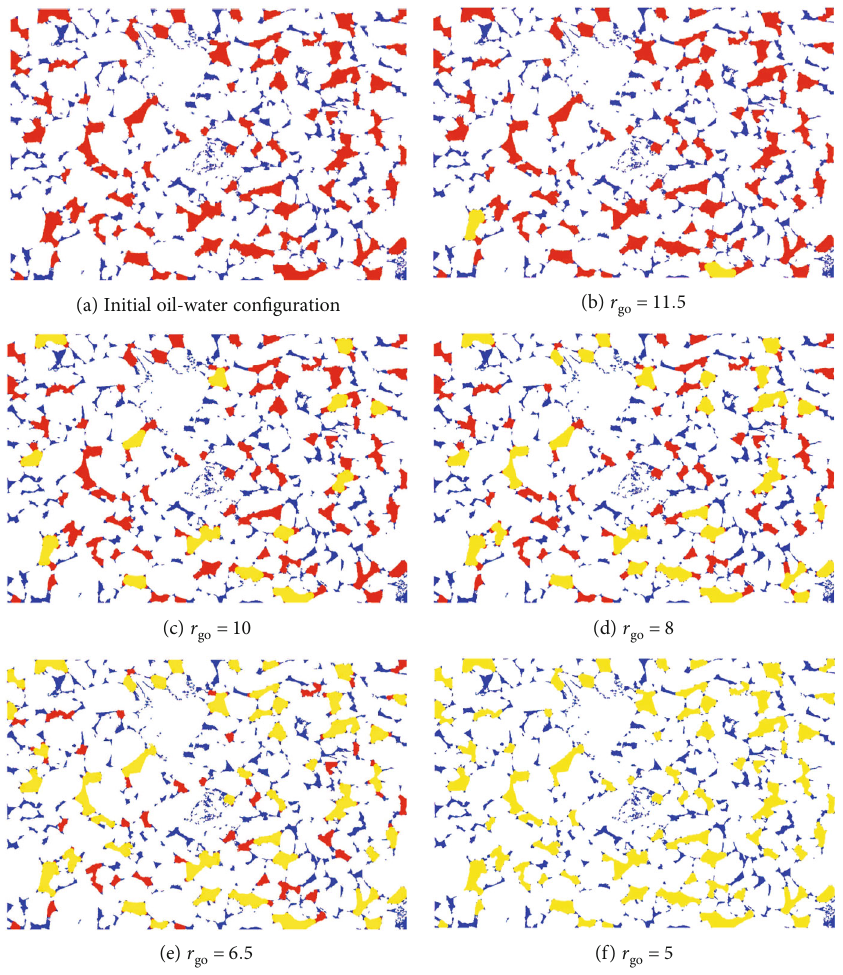
Figure 8: Three-phase fl uid con fi gurations at selected gas-oil capillary pressure radii (given in pixel lengths) during gas invasion at a constant = 5 pixel lengths ( P = 1 : 9608 × 10 4 Pa), in a strongly water-wet spreading system. Yellow region: gas; oil-water capillary pressure radius, r ow cow red region: oil; blue region: